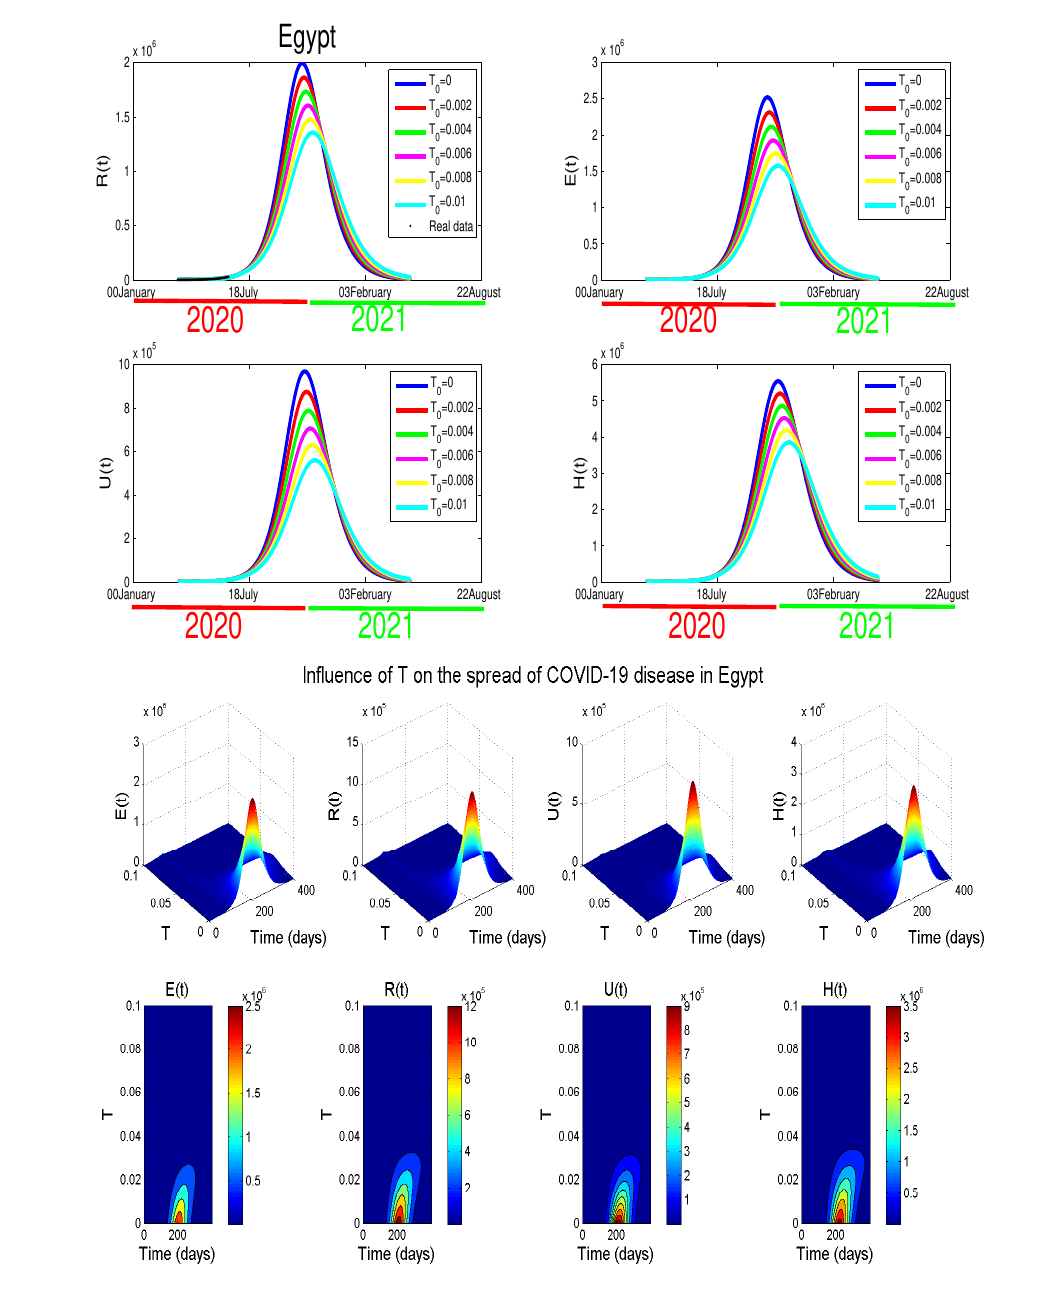
Figure 9. The impact of chaotic tests on the spread of the COVID-19 disease in Egypt. 4. The Influence of Relaxation of the Measures on the Spread of COVID 19 in the North African